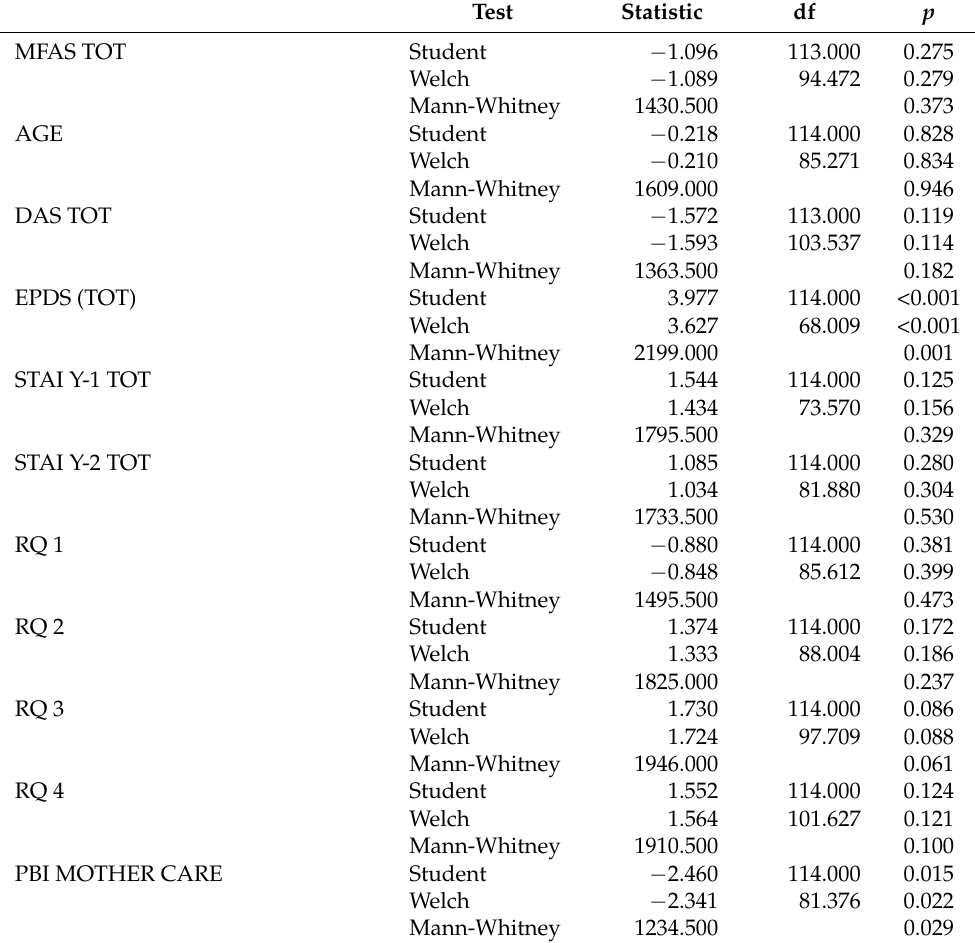
Table 6. Independent samples t-test—continuous variables versus breastfeeding three months after partum